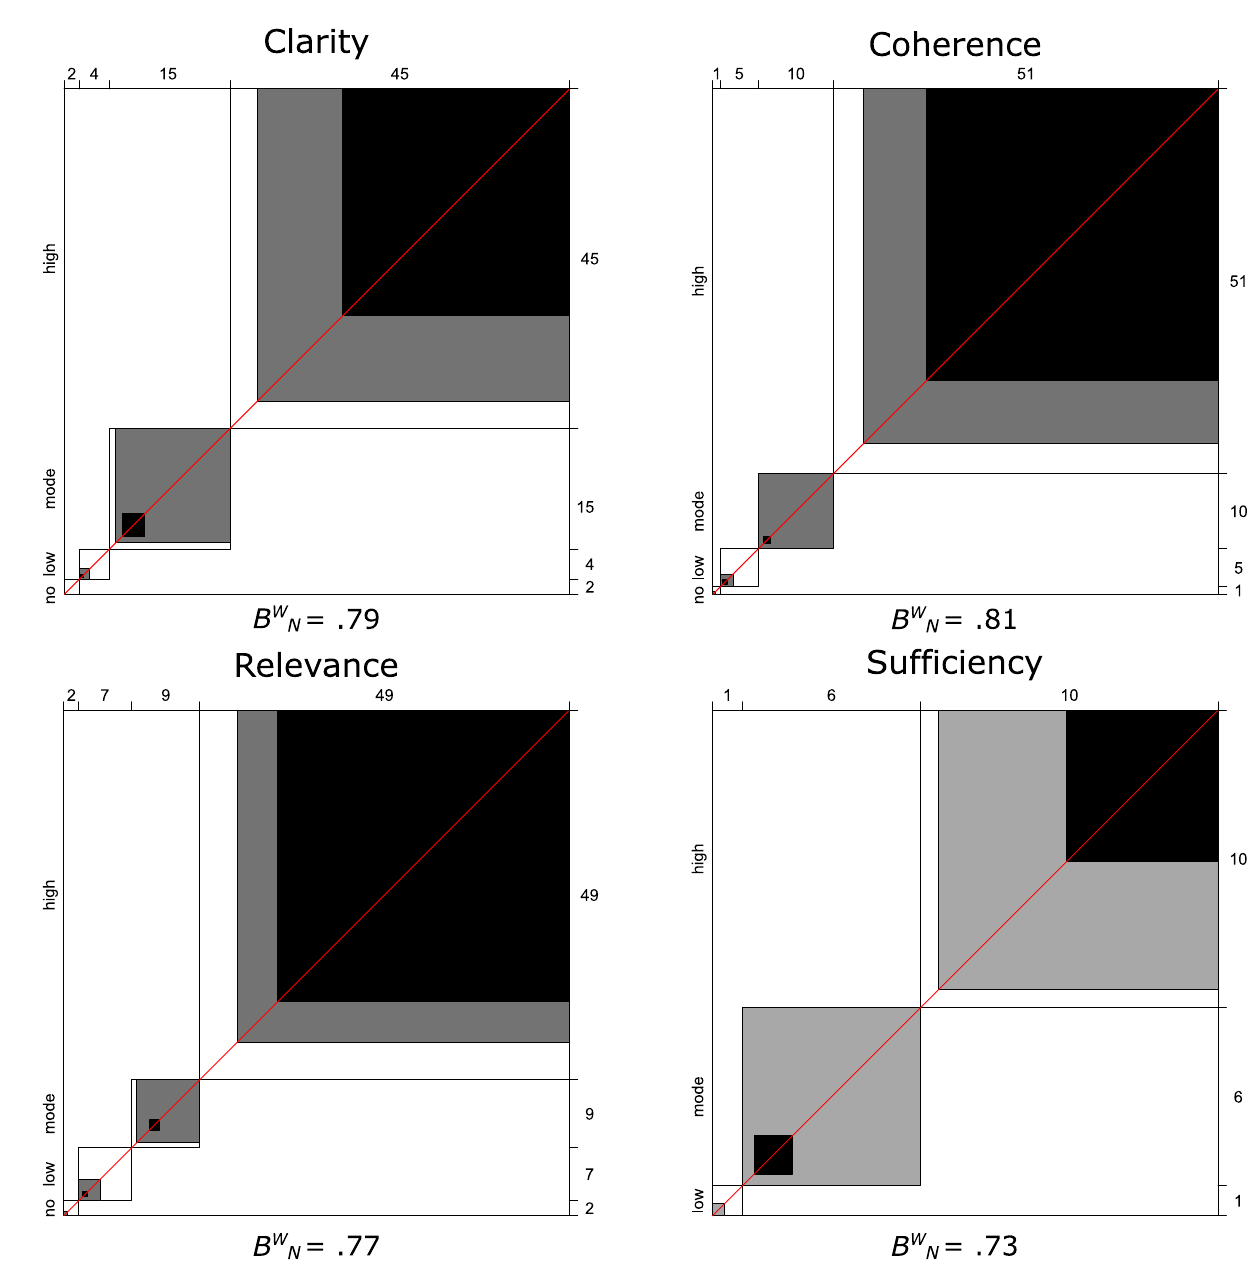
Fig 1. Results of Bangdiwala interobserver agreement analysis regarding content validity.